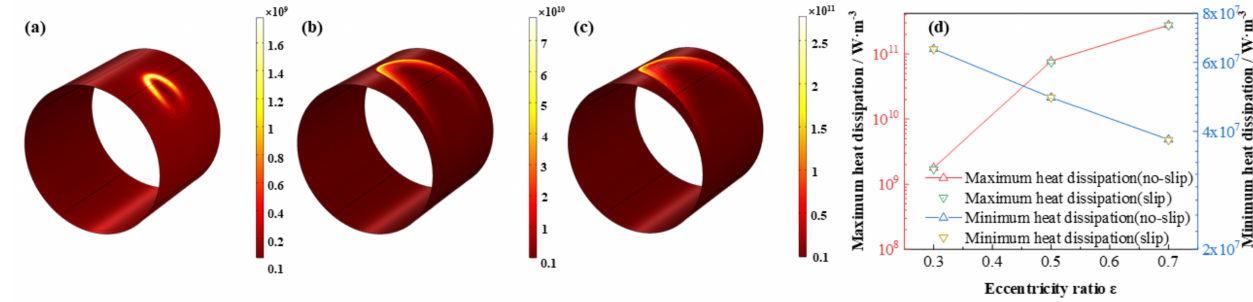
Figure 11. Comparison of the heat dissipation distribution under different eccentricity ratios. ( a ) ε = 0.3; ( b ) ε = 0.5; ( c ) ε = 0.7; ( d ) maximum/minimum heat